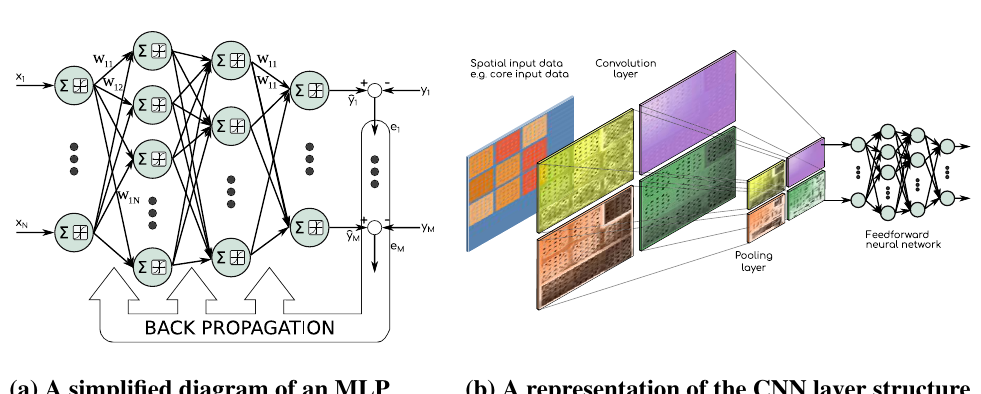
Figure 2: Deep learning topologies